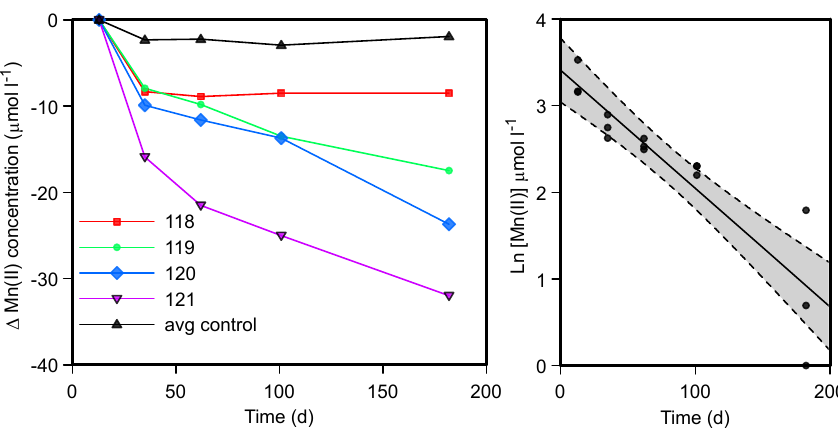
Fig. 8. Left panel: Mn oxidation rate incubation data showing Mn oxidation (as dissolved Mn disappearance) at 119 to 121m depth. Incubations of water from 118m are not significantly different than the controls killed with formaldehyde. Right panel: natural log of Mn(II) concentration versus time from 119–121m, demonstrating the applicability of first order reaction kinetics in Lake Matano. Table 4. Saturation Indices (SI) of Mn minerals in Lake Matano’s bottom waters calculated as SI=log (IAP/ K sp ) , where IAP is the ion activity product and K sp is the solubility product, calculated assuming 25 ◦ C and 1atm pressure. Calcite and MnHPO 4 K sp were obtained from the MINTEQA2 thermodynamic database.